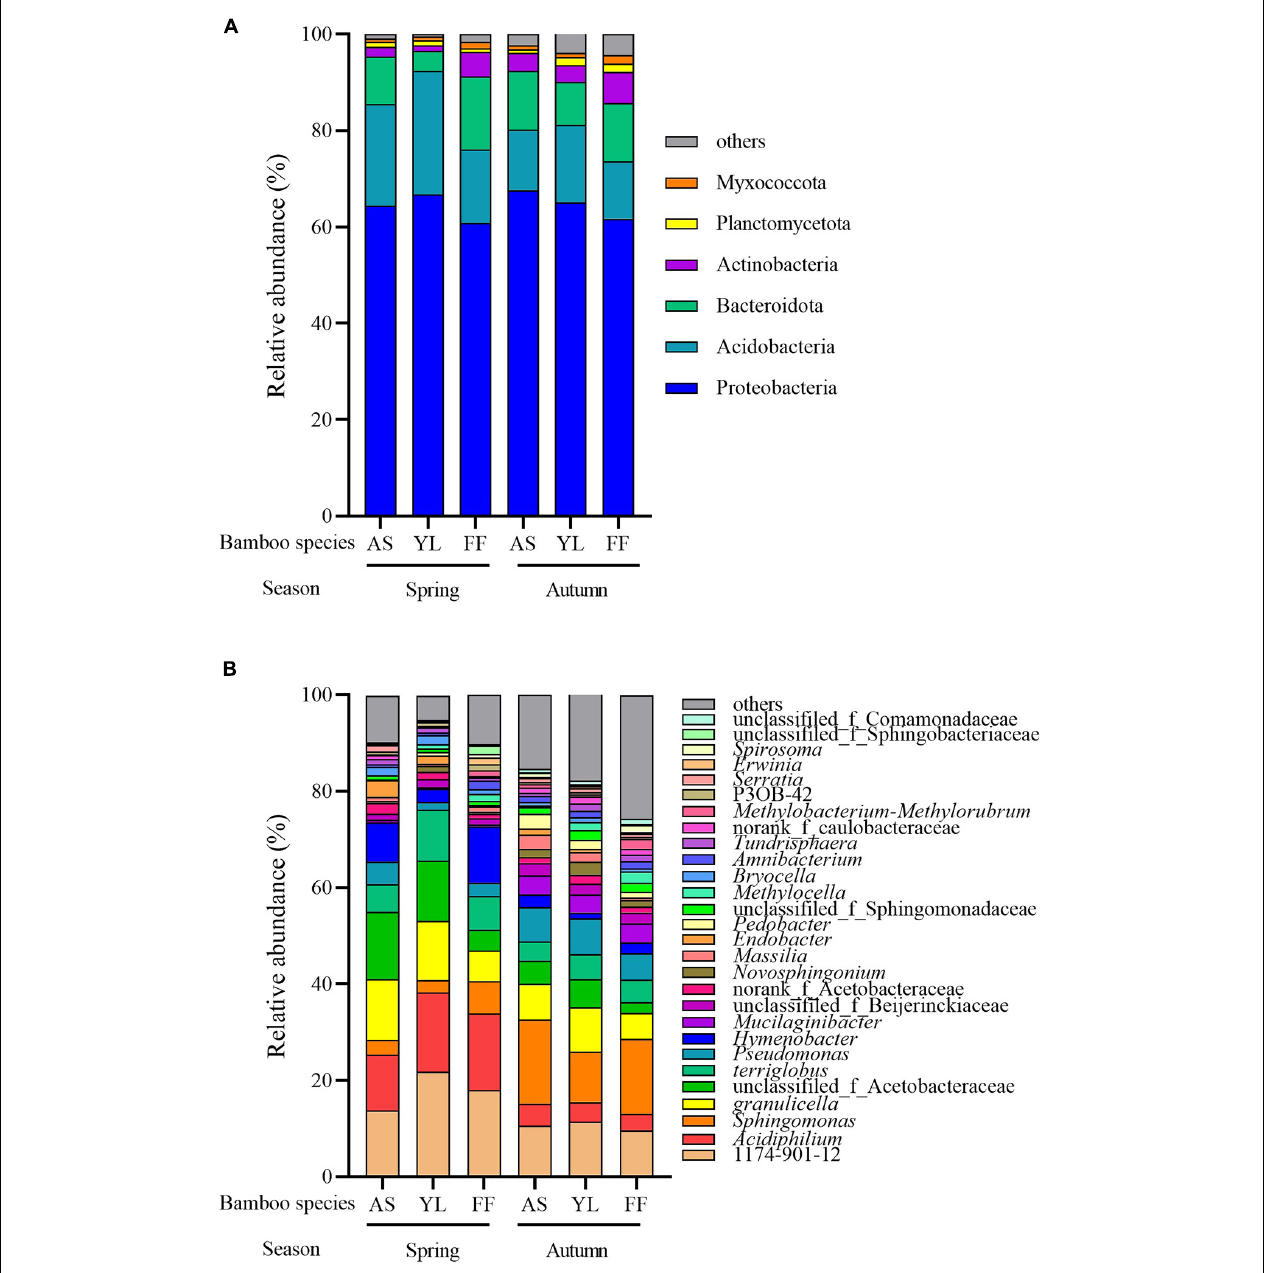
FIGURE 2 | Relative abundance of different phyllosphere bacterial phyla (A) and genus (B) among A. spanostachya (AS), Y. lineolate (YL), and F. ferax (FF) in spring and